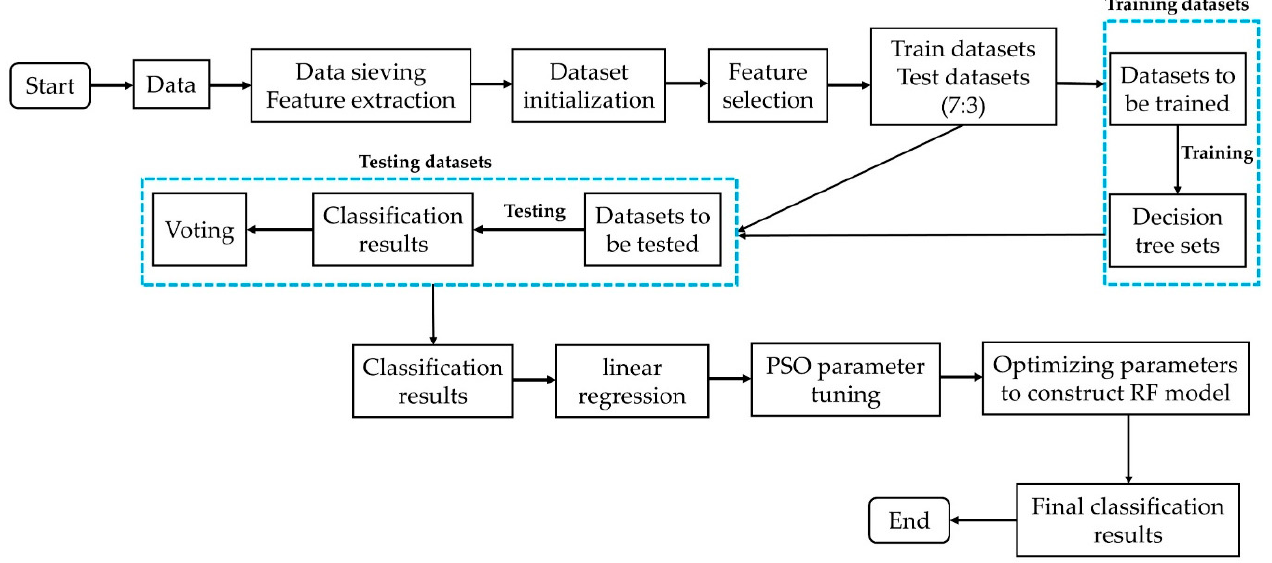
Figure 4. Flow chart of optimizing the parameters of random forest based on PSO.